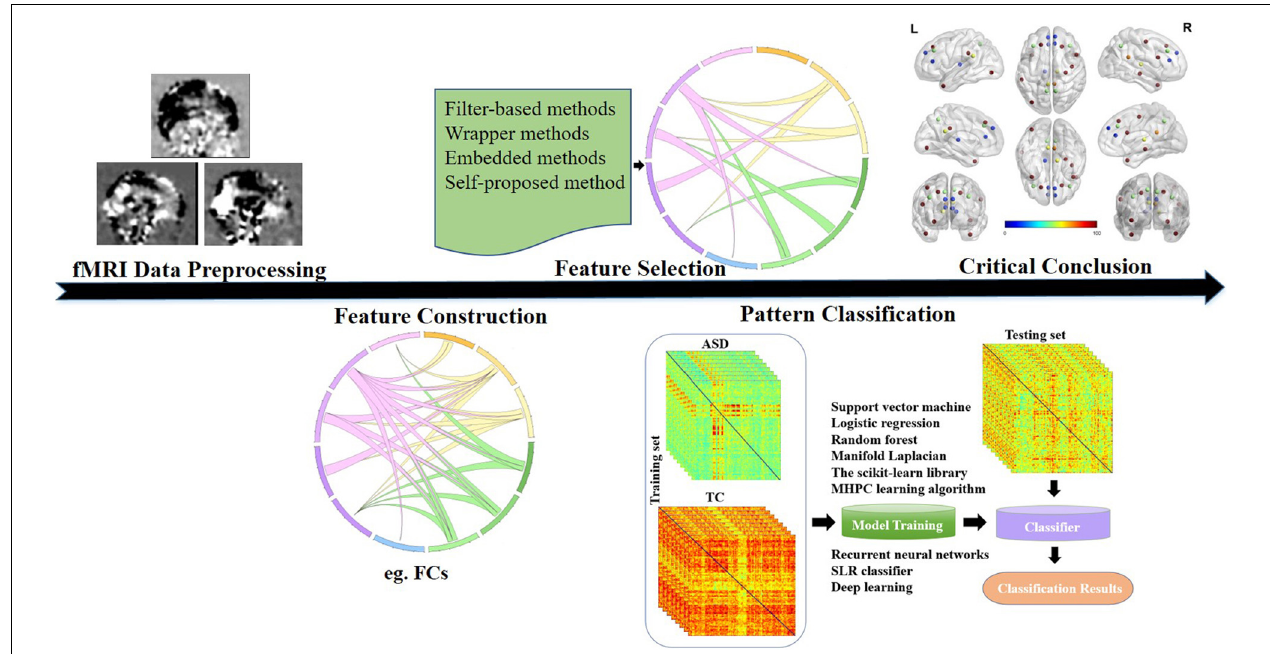
FIGURE 1 | General process of ASD studies using fMRI data and machine learning (taking FC features for example). ASD, autism spectrum disorder; fMRI, functional magnetic resonance imaging; FC, functional